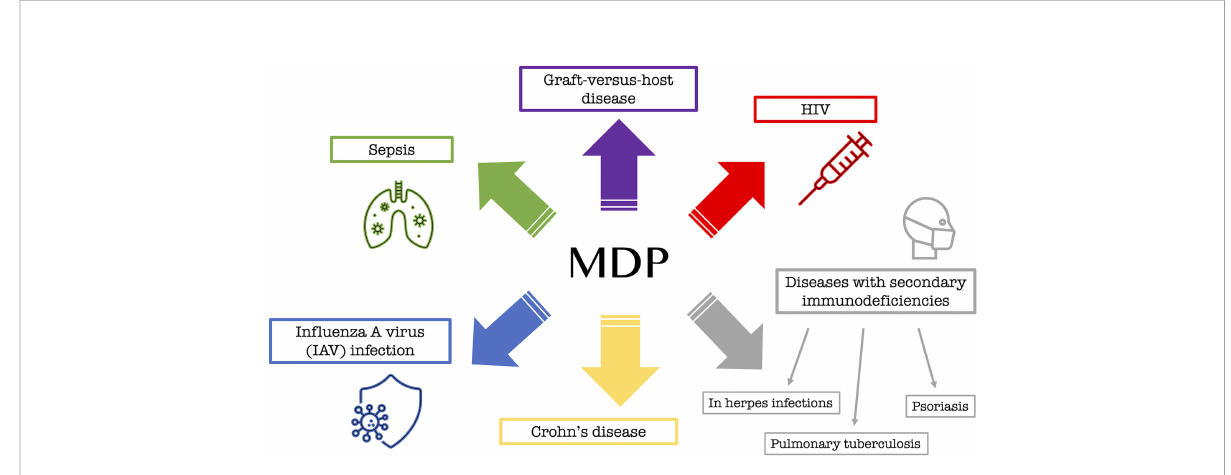
FIGURE 3 MDP analogs in biological use for the treatment of bacterial or viral